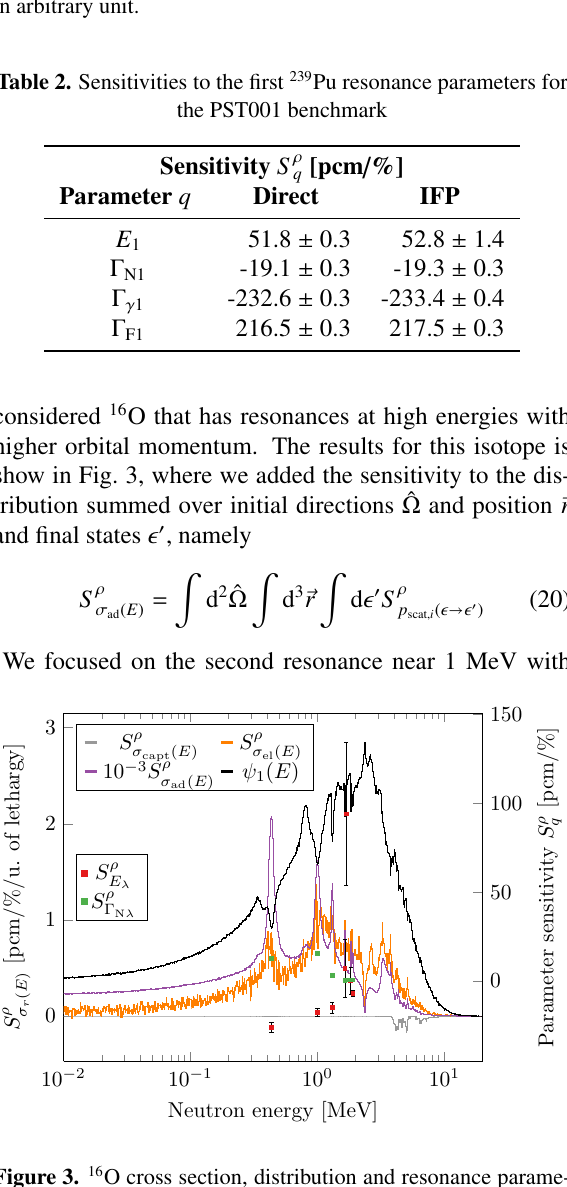
Figure 2. 239 Pu cross section and resonance parameter sensitiv- ities for the PST001 benchmark. The neutron flux is also shown in arbitrary unit.